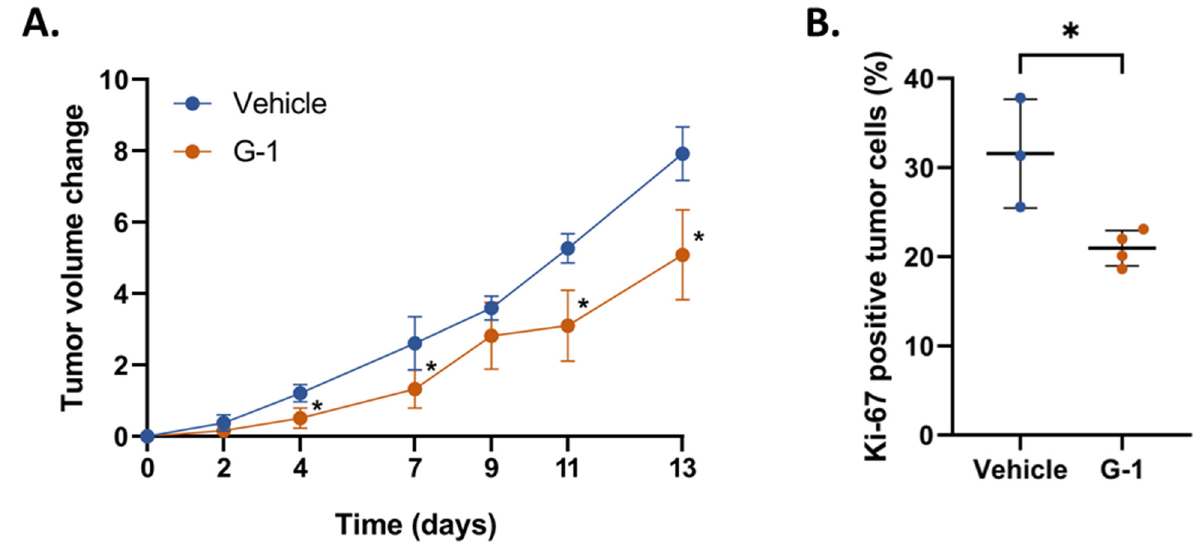
Figure 1. G-1 significantly decreases tumor growth in nude mice. ( A ) U87MG cells were subcutaneously injected into nude mice. Tumor volume change (TVC: for each mouse, the difference between tumor volume at each point of the experiment and tumor volume at the time of animal randomization) was measured during 2 weeks of treatment every 2 days. ( B ) Quantification of Ki-67-positive cells in tumors of the vehicle or G-1-treated mice. The data are presented as the mean ± SD. Significance level was determined using t -tests, with * indicating p < 0.05. Vehicle, n = 3; and G-1, n = 4.